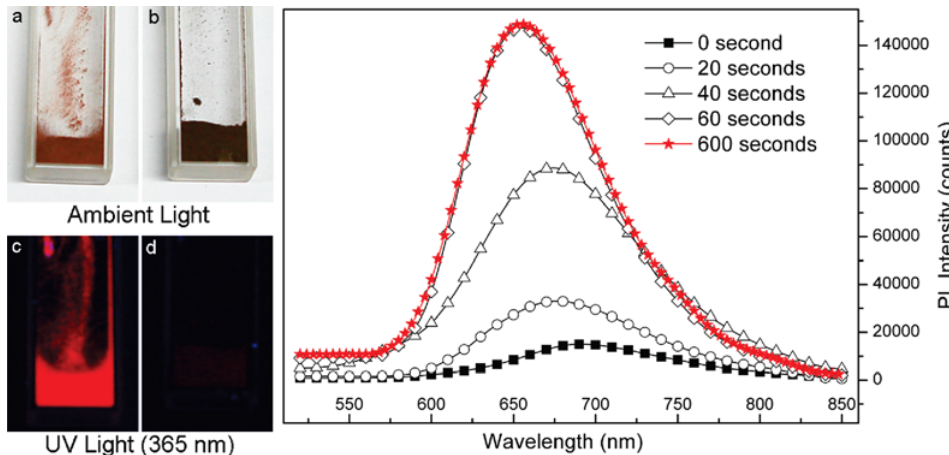
Figure 13. Photographic images of (a) the red form, and (b) the black form of PIr(qnx). Luminescence images of (c) the red form, and (d) the black form of PIr(qnx). Photoluminescence spectra of the black form exposed to acetonitrile vapor at different periods of time. Reproduced with permission from